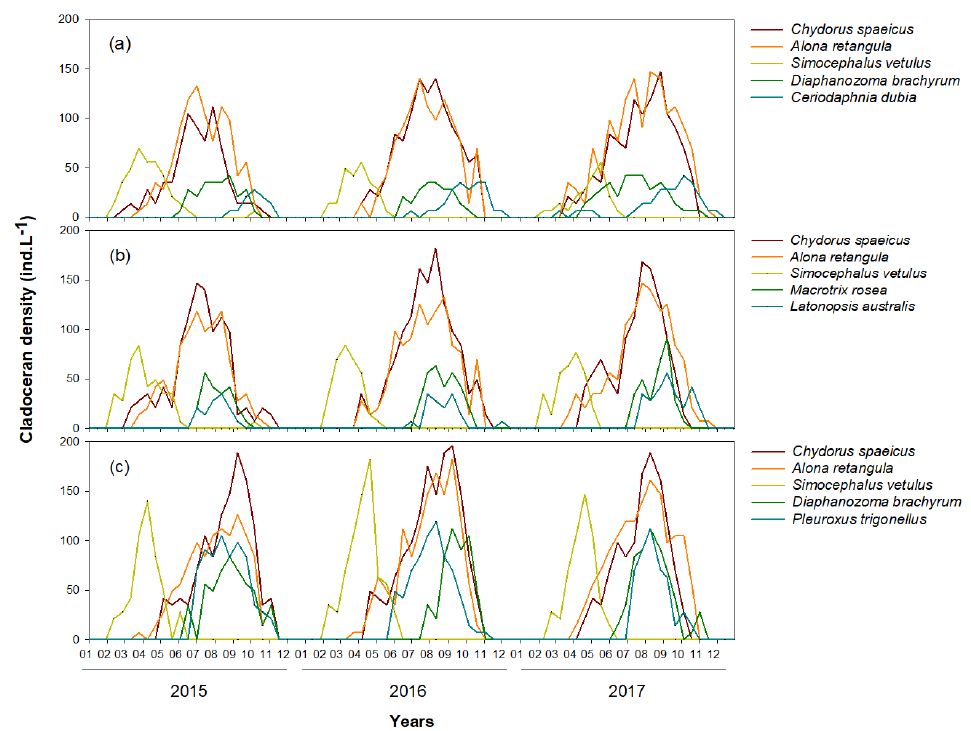
Figure 2. Time-series fluctuations in dominant cladoceran species in ( a ) Upo Wetland, ( b ) Jangcheok Wetland, and ( c ) Beongae Wetland from 2015 to 2017.